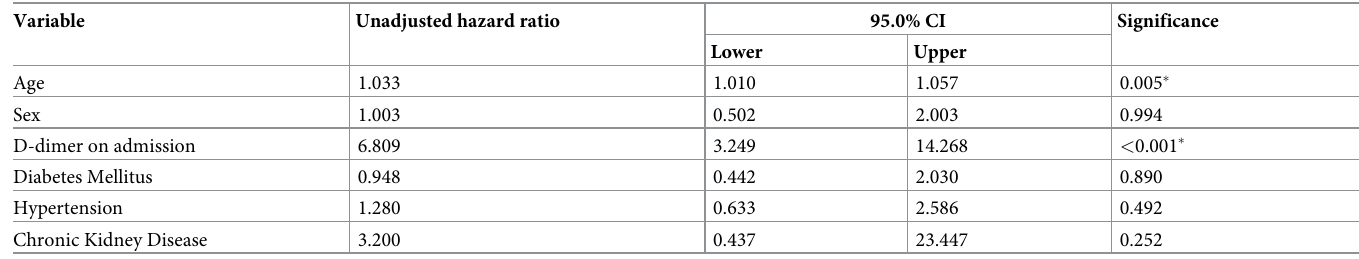
Table 3. Univariate Cox regression analysis.